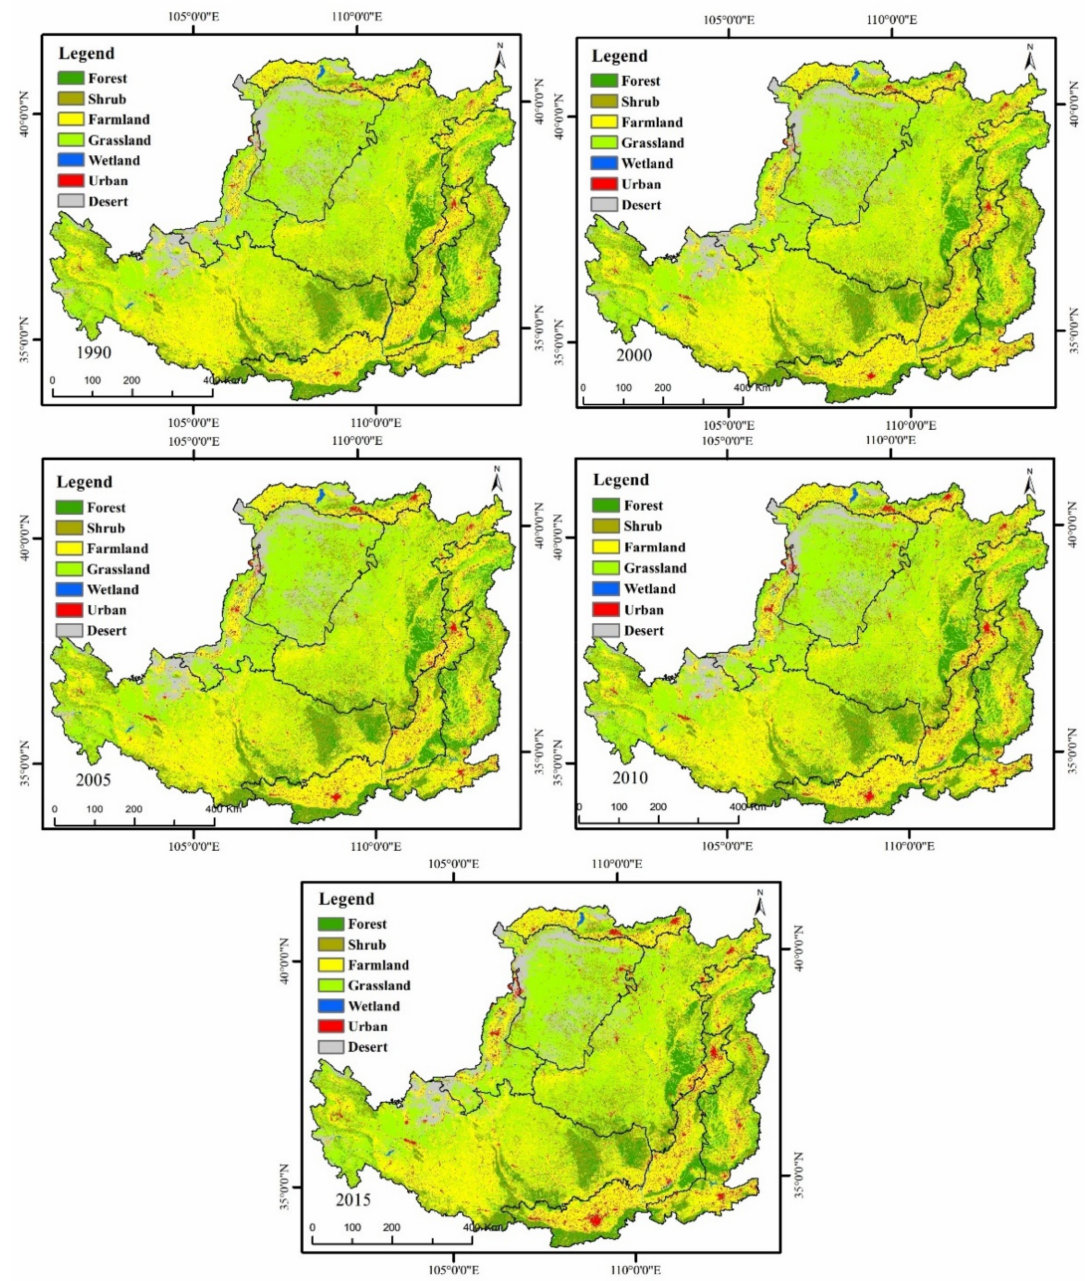
Figure 3. Spatial distribution of ecosystems in different periods of the Loess